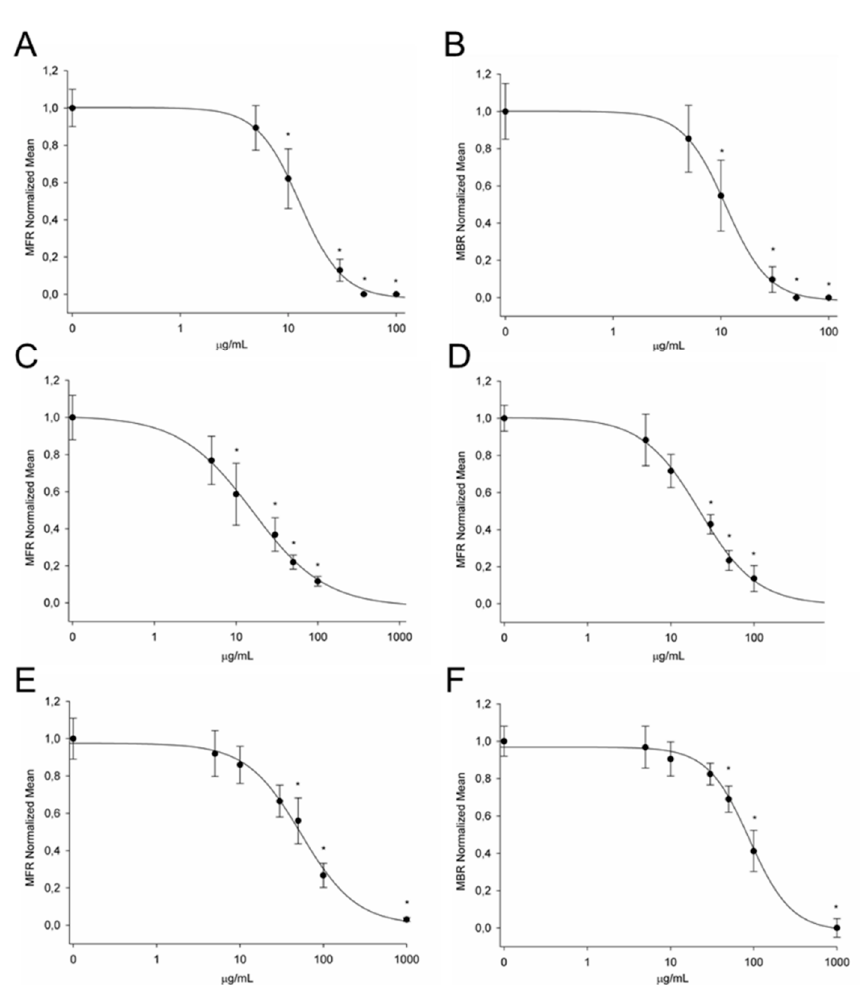
Figure 6. E ff ects of increasing concentrations of Nj, Vo and Vj EOs on cortical neuron networks activity. Nj EO showed a concentration-dependent inhibition for both mean firing rate (MFR) ( A ) and mean burst rate (MBR) ( B ), with IC 50 values of 12.8 and 11.1 µ g / mL, respectively (n = 6). The EO of Vo showed similar but less strong e ff ects on MFR ( C ) and MBR ( D ), with IC 50 values of 16.0 and 22.2 µ g / mL, respectively (n = 5). Vj EO was the less e ff ective to induce the inhibition of neuronal activity with IC 50 values of 54.4 and 88.7 µ g / mL for MFR ( E ) and MBR ( F ), respectively. * p < 0.05.